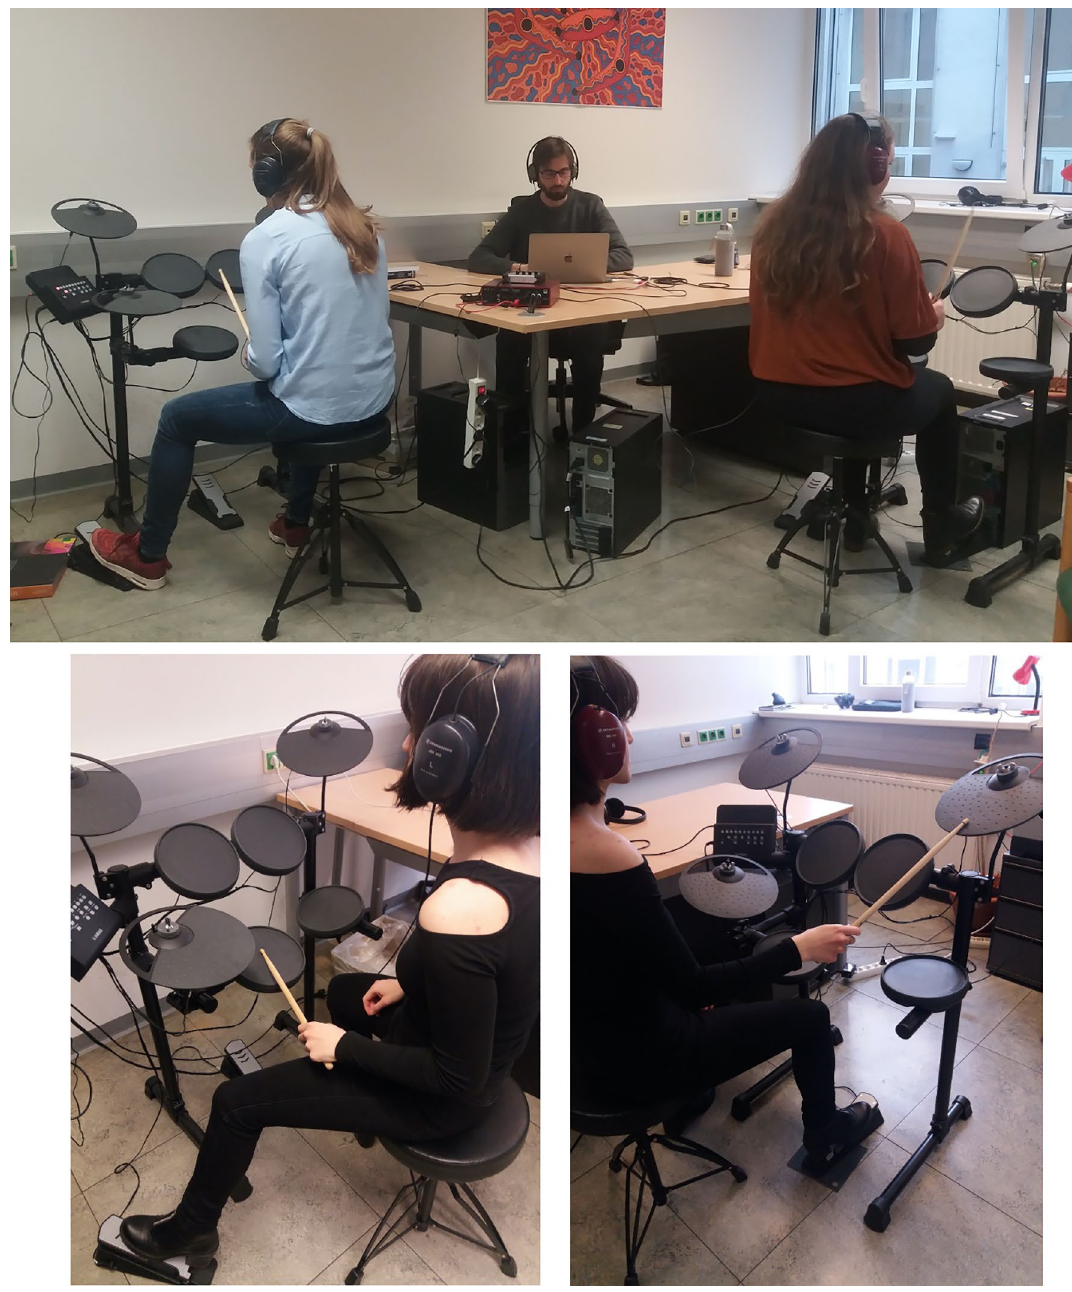
Figure 4. Experimental setting. Participants playing Drumkit A (on the left) only used their left hand and left foot to play snare drum and hi-hat pedal. Conversely, those playing Drumkit B (on the right) only used their right hand (to play ride cymbal) and right foot (bass drum). Participants could not see each other as they were giving their back to their partners. Participants in the control group did all tasks by themselves. They were asked to play either Drumkit A or Drumkit B, using the same pads assigned for participants in the duo group. (The picture above depicts author 1 at the center with two participants photographed from behind, so that their face will not be visible. In the picture below, author 3 illustrates in more details how the task was stimulus, indicating how tight participants were playing in relation to the stimulus; (ii) standard deviation (SD) of asynchronies between performance and stimulus, indicating how stable participants were playing with the stimulus; and (iii) the similarity between notes played in the performance and the stimulus, indicating how well participants followed the pattern of individual instruments on the drumkit. For all of these measures, double hits, defined as note onsets following another note onset in a time window shorter than 125 ms (i.e., shorter than a sixteenth note), were removed. The whole performances were divided into two groups of segments differentiat- ing between play-along and break segments (see Fig. 2). This process gave rise to 21 play-along segments (the last